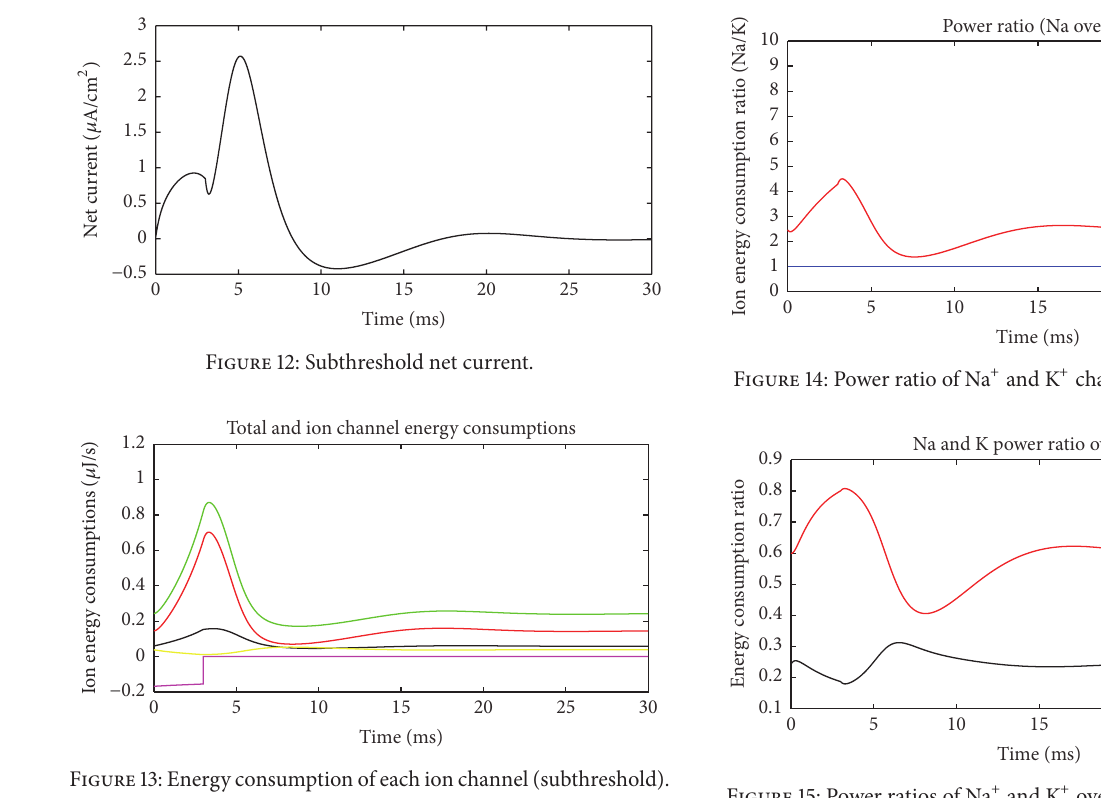
Figure 15: Power ratios of Na + and K + over total (subthreshold).